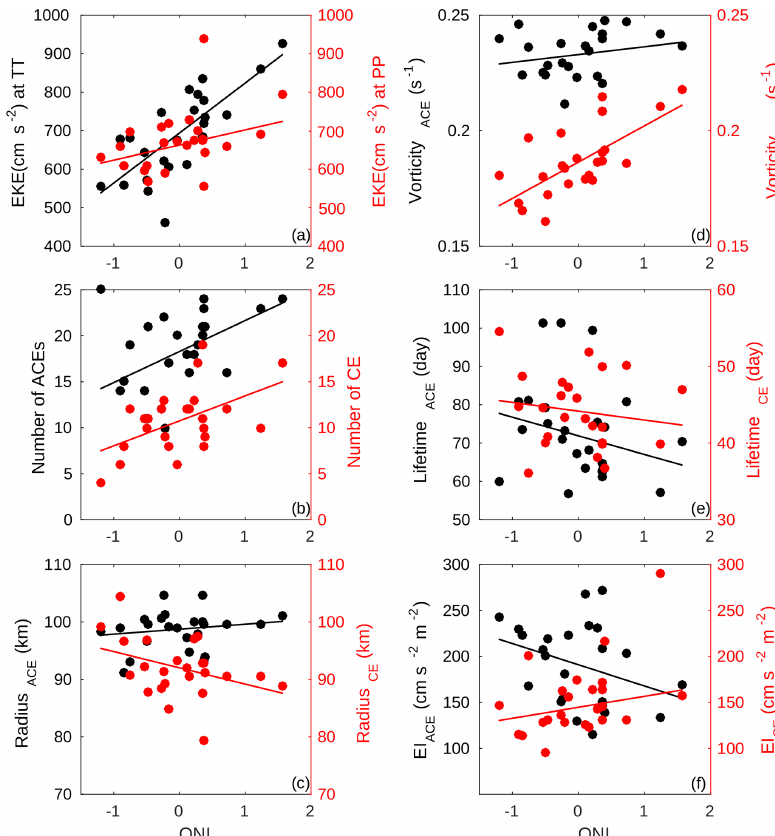
Figure 9. Relationship between the Ocean Niño Index (ONI) based on the Oceanic Niño 3.4 Index and (a) EKE in the TT and PP gap wind regions, (b) number of eddies, (c) radius of eddies, (d) vorticity of eddies, (e) lifetime of eddies, and (f) intensity of eddies, all with lifetimes longer than 28d. The black and red dots in (a) refer to EKE in the TT and PP, and in ( b – f ) they refer to eddy characteristics of ACEs and CEs, respectively. The best fits for the scatterplots are shown as solid red and black lines. EKE values used in (a) correspond to areas with an EKE value larger than the average EKE throughout the period 1993 to